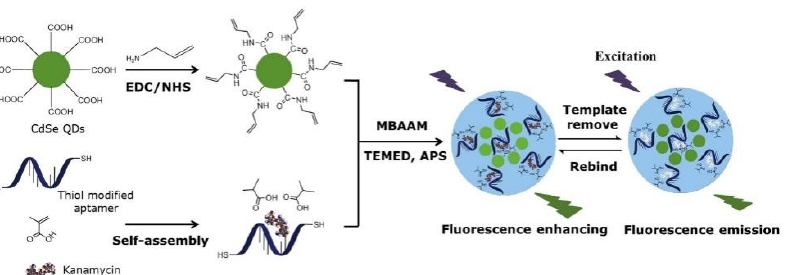
Figure 11. Schematic illustration of the preparation and recognition process for the fluorescent aptamer-functionalized MIPs [117].